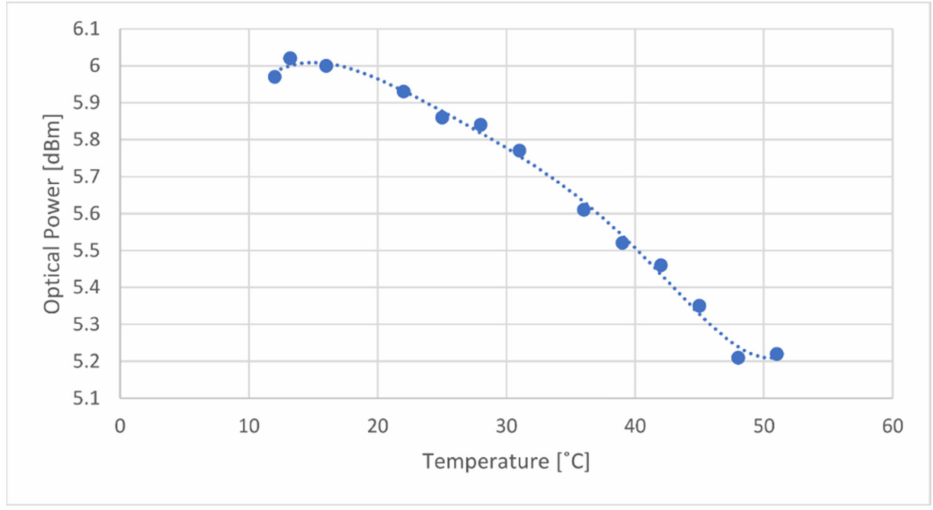
Figure 7. Laser emitted power as a function of temperature for a constant current of 25 mA. Optical power varies about 0.8 dBm between both ends of the temperature range, decreasing as temperature increases, which is coherent with the literature [13]. In order to compensate for this variation, a polynomial curve, of degree 6, was shown to be the best fit for the measured values. This equation will allow the system to predict the optical power emitted from the laser, given its operating